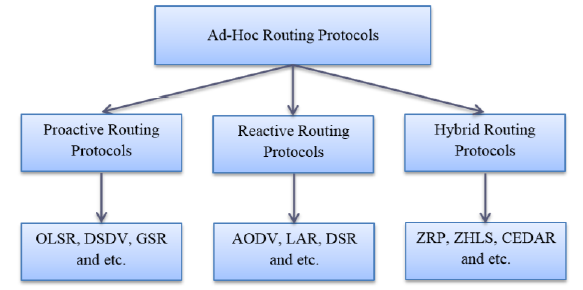
Fig. 1. The main types of routing